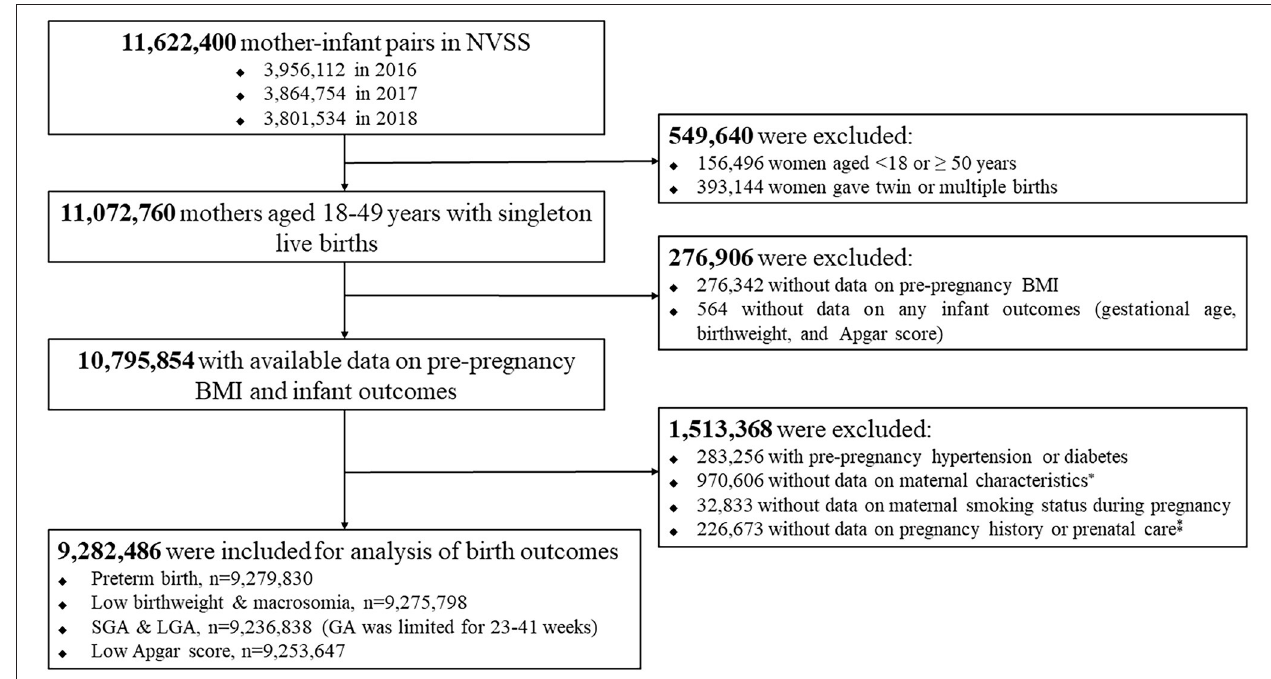
FIGURE 1 | Flow chart of inclusion/exclusion of the study population. *maternal age at delivery, race/ethnicity, education level, marital status; ‡ The number of live births, and the total number of prenatal care